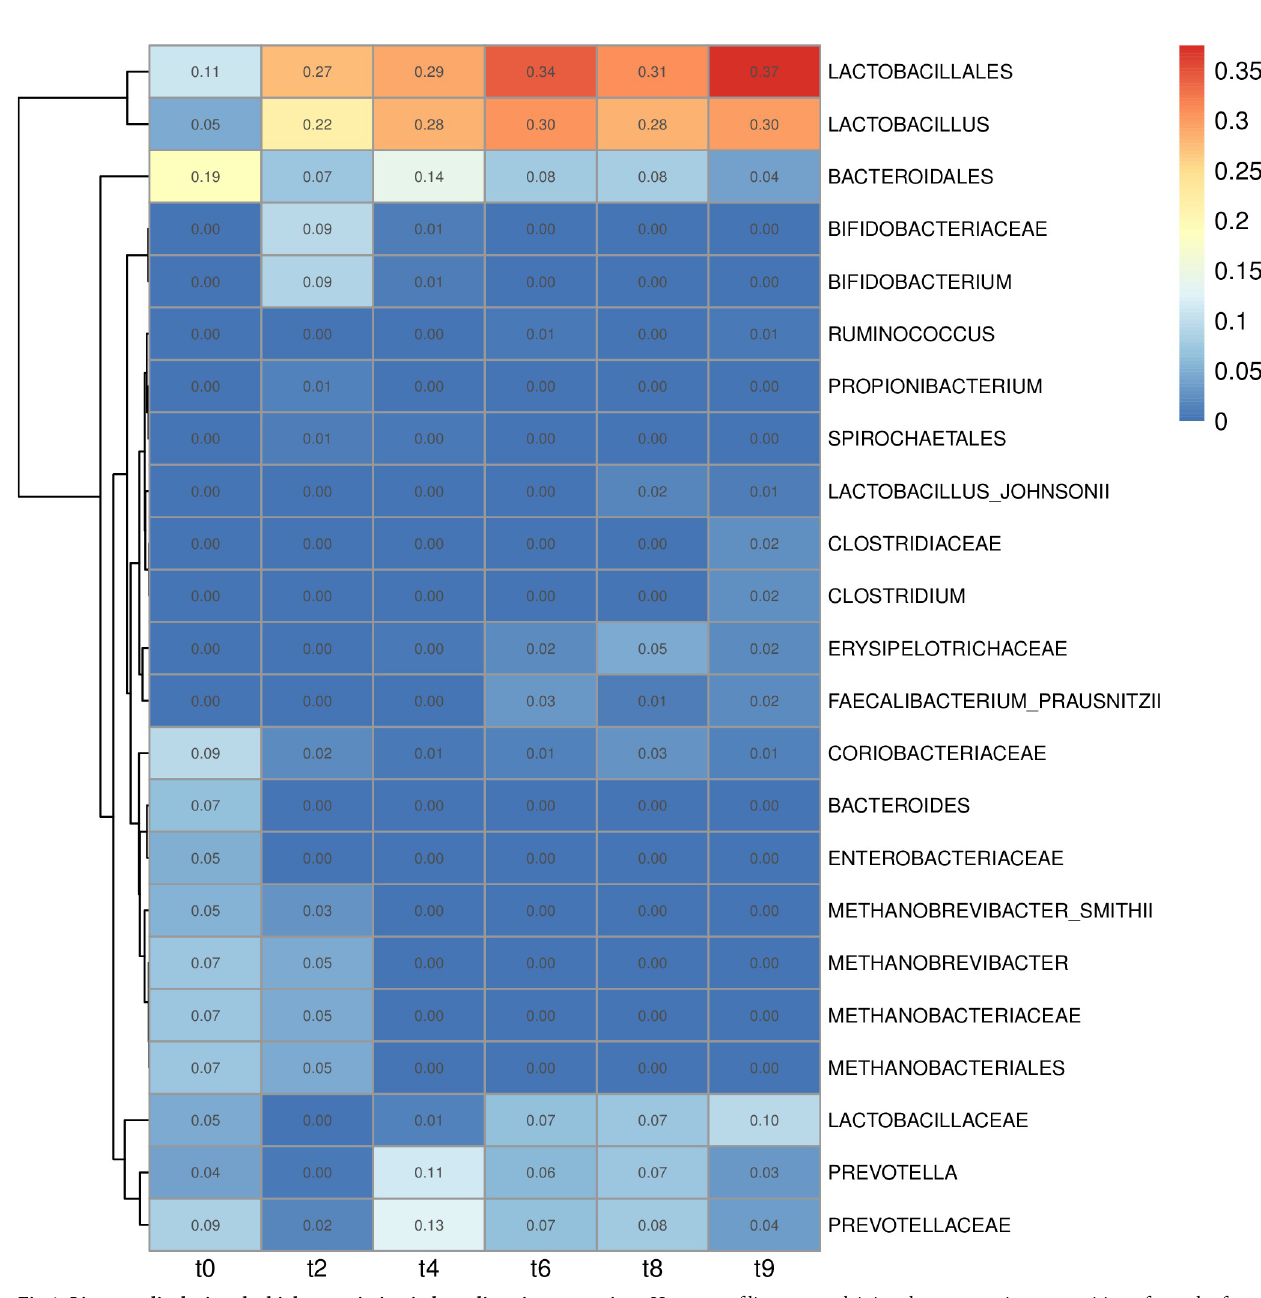
Fig 3. Effect of time on beta diversity. Principal component analysis (PCA) of samples. PCA from edge component analysis with PhyloSift (top) and PCA from 20 most abundant 16S reads extracted with SortMeRNA (bottom). In the top, distribution of samples on either side of the plot (left versus right; top versus bottom) reflect the lineages that were found to explain the variation. Samples are color coded by time post-weaning (days). In the lower plot, arrows indicate which of the 20 lineages contributed to the variation of samples across time, where arrows thickness represents a higher (thicker) or lower (thinner) contribution. Samples are color coded by time point during the trial (t0: start of the trial/first day after weaning; t10: last day of the trial/40th day after weaning).